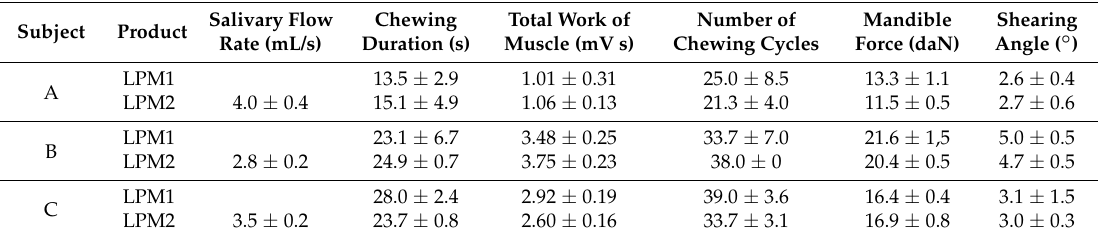
Table 2. Physiological results obtained for each subject during chewing LPM1 and